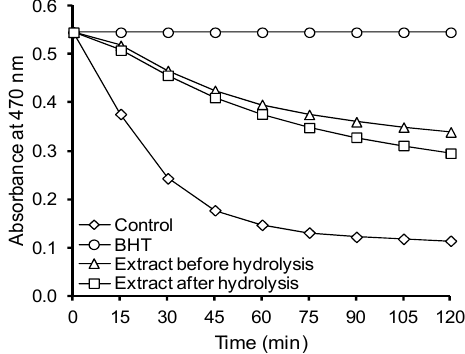
Figure 8. Antioxidant activity of the flaxseed extracts in β -carotene-linoleate emulsion system.